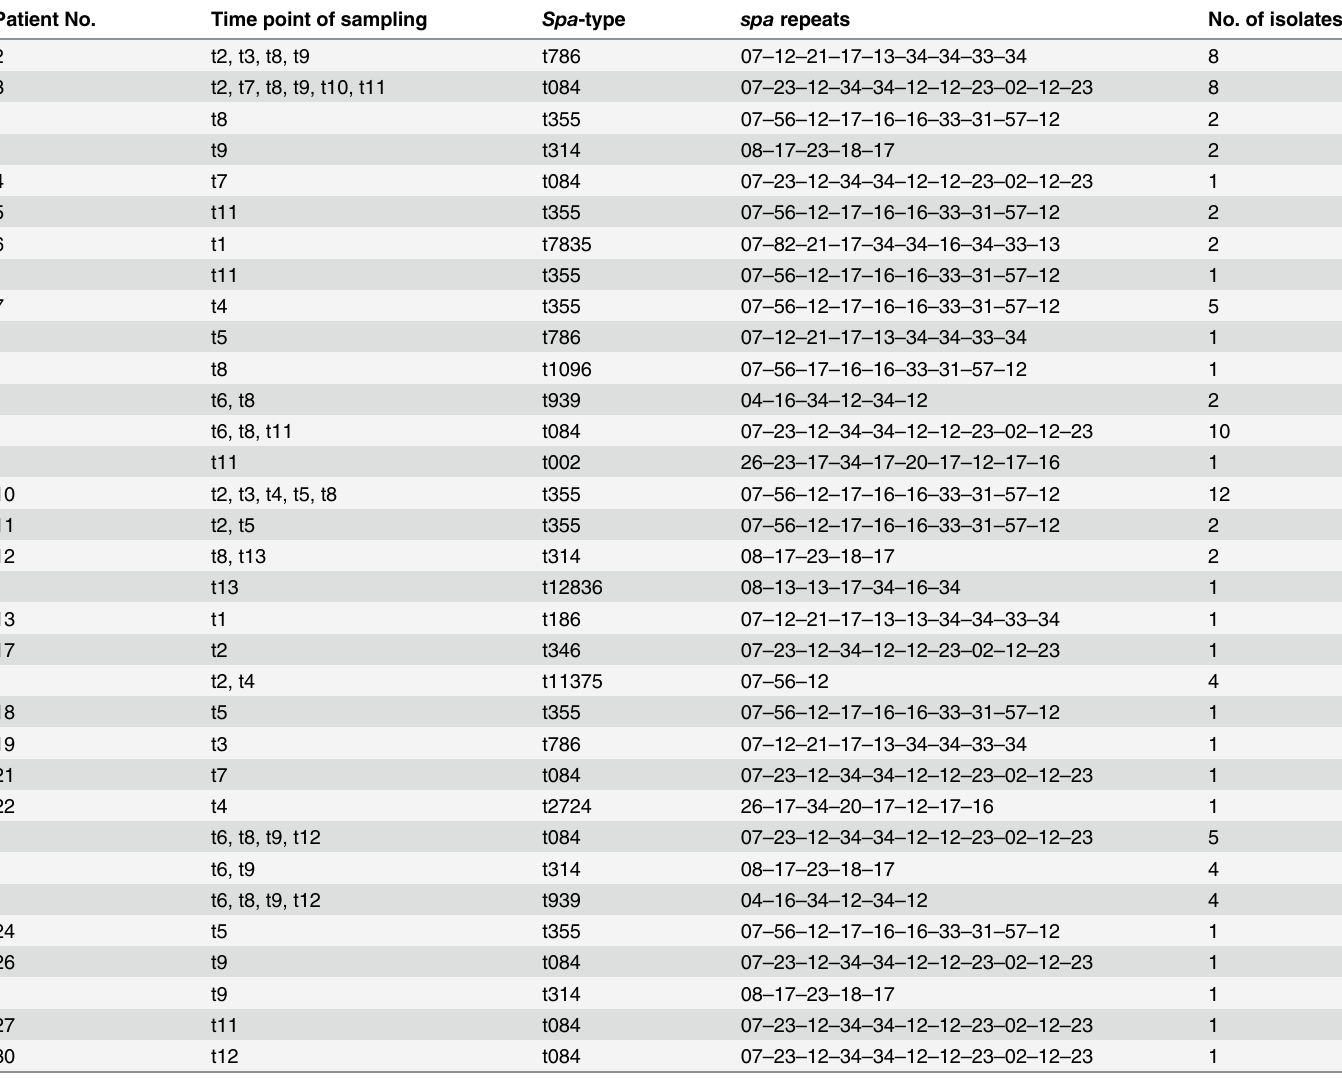
Table 1. spa -types of 91 S. aureus isolates from the anterior nares and wounds of 19 BU patients. Patient